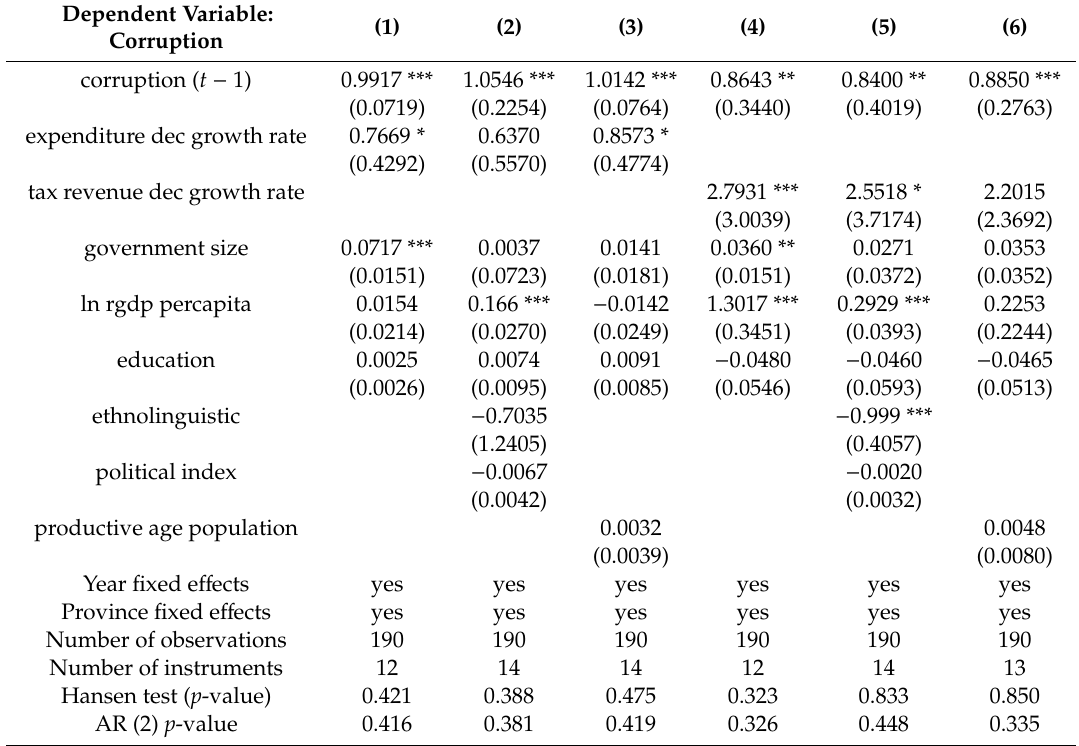
Table 5. The System Generalized Method of Moments (GMM) Model. (Fiscal Decentralization is Measured as Percentage